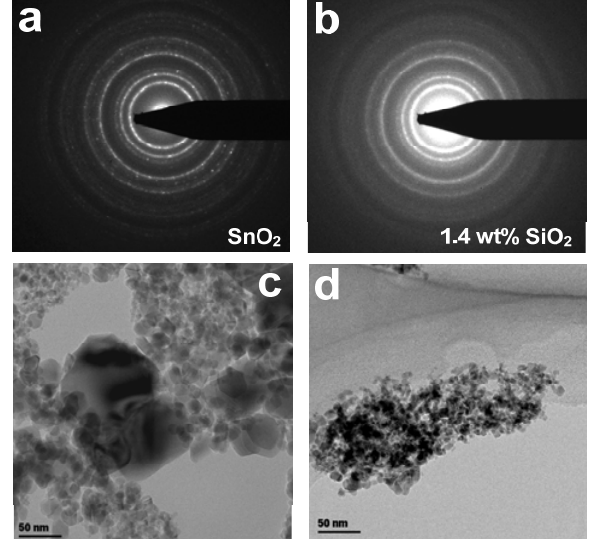
Figure 2. ED patterns of pure ( a ) SnO nanocomposites after 4 h sintering at 400 °C and corresponding transmission electron microscopy (TEM) images ( c,d